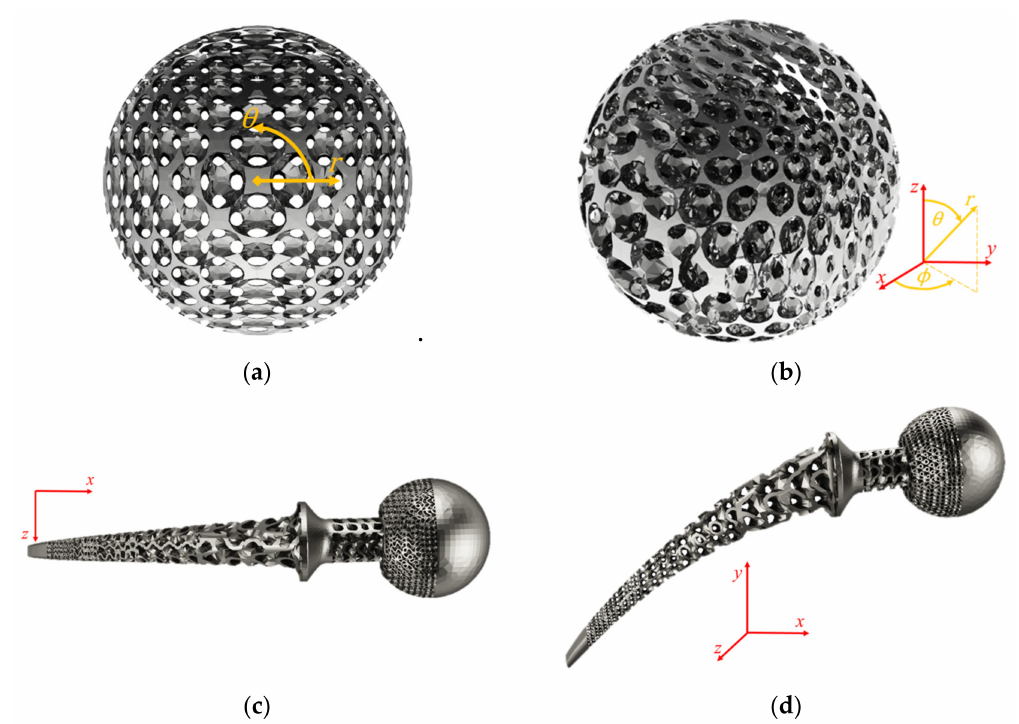
Figure 4. Size graded lattice structures: ( a ) side view and ( b ) isometric view of a sphere filled with TO FCC unit cell and